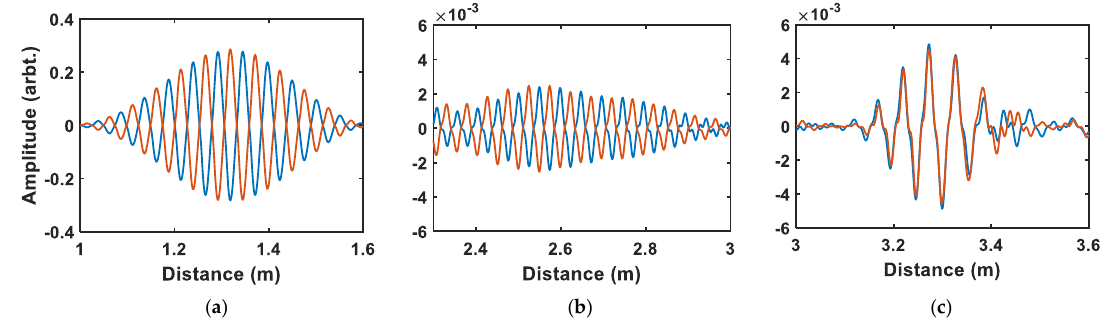
Figure 12. Two sets of results after swapping the inputs to adaptive filter where ( a ) shows the signals received from the backward direction, ( b ) shows the flexural noise, and ( c ) shows the defect signal.